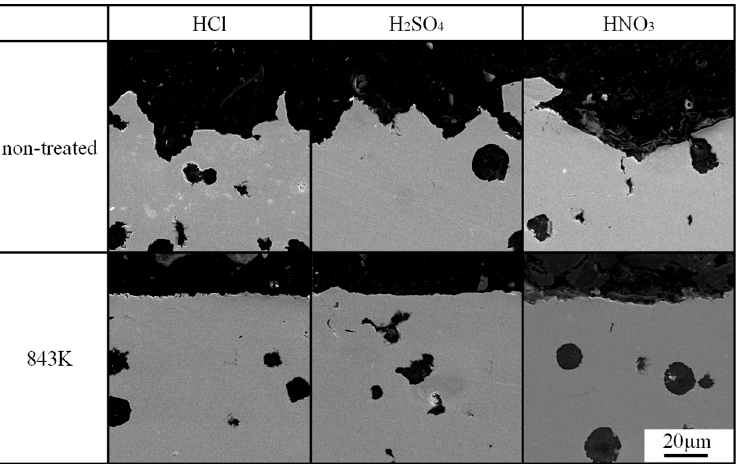
Figure 9. Cross-sectional SE images of ASPN-treated samples after immersion in 1N HCl, H 2 SO 4 , and HNO 3 .